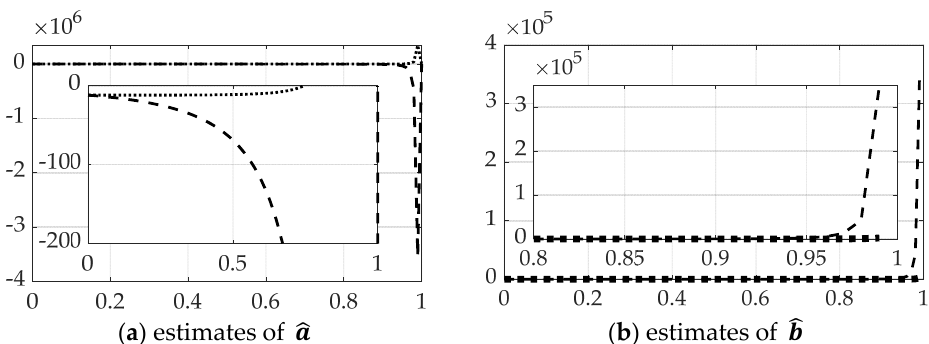
Figure 12. Comparison of real-time optimal methods with scaled time on the abscissae and respective ordinates titled in the subplot captions: dashed line is real-time optimal using backslash, dotted line is real-time optimal using LU-inverse with singular switching. ( a ) Estimates of ˆ a , ( b ) estimates of ˆ b . The ranges of the zoomed view in the inset are indicated by the respective scales. Table 8. Comparison of real-time optimal decision methods using LU-inverse matrix inversion.